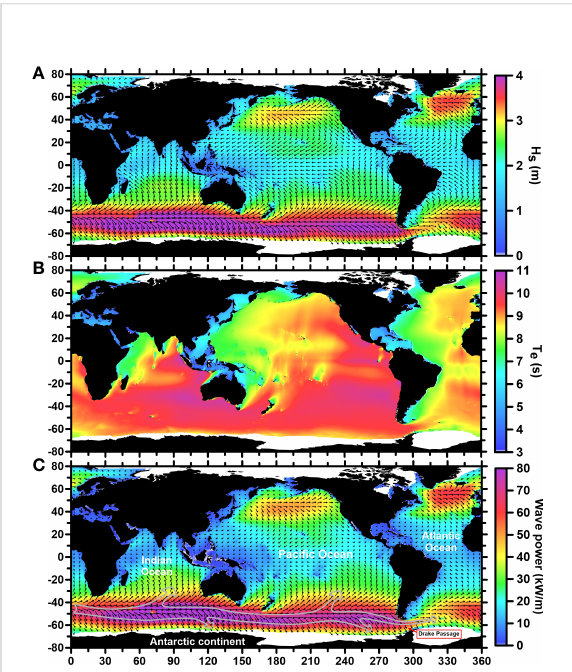
FIGURE 1 Spatial distributions of averaged total wave fi elds per 0.5°×0.5° cell from 1979 to 2020. (A – C) Yearly-averaged signi fi cant wave height (m), wave energy period (s), and wave power (kW/m) fi elds. The arrows represent the averaged direction and the magnitude corresponding to the H s and wave power,